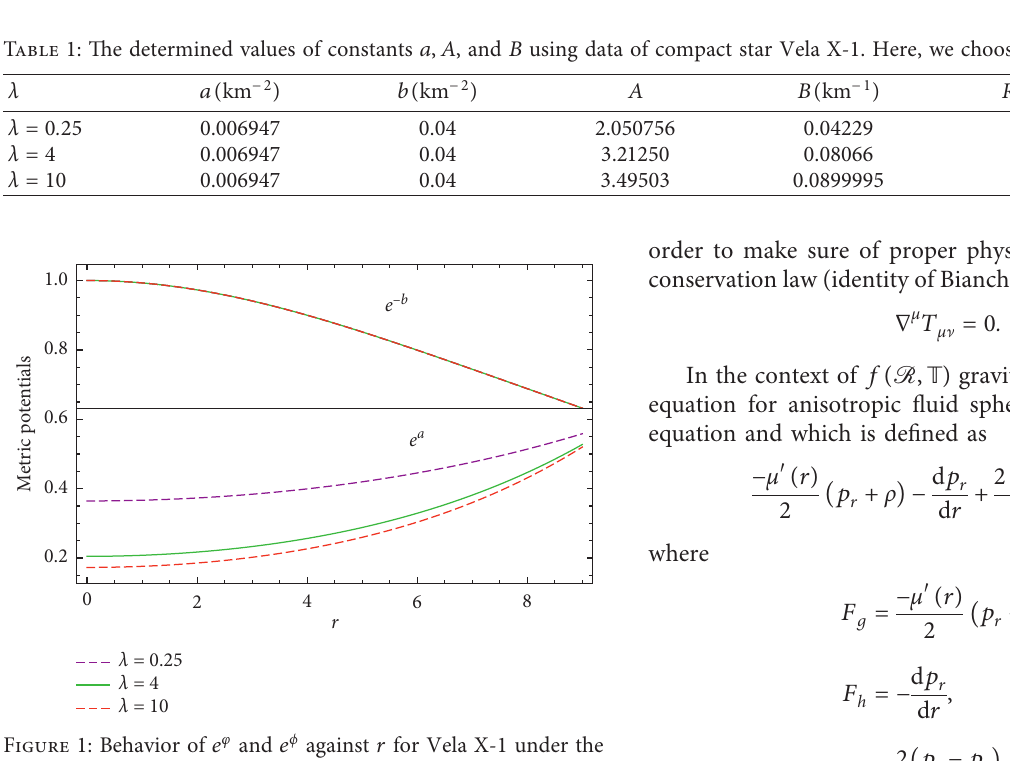
Figure 1: Behavior of e φ and e ϕ against r for Vela X-1 under the values of parameters from Table 1 for λ � 0 . 25 , 4, and 10.